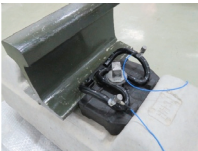
Figure 10: Assembly modal test of the